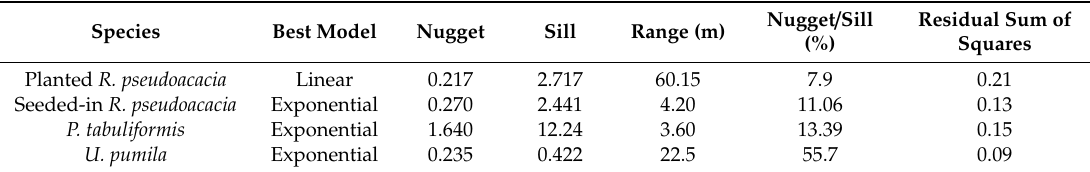
Table 3. Best fitted semivariogram model and the corresponding parameters for each tree species in Pingshuo opencast coal mine, China.